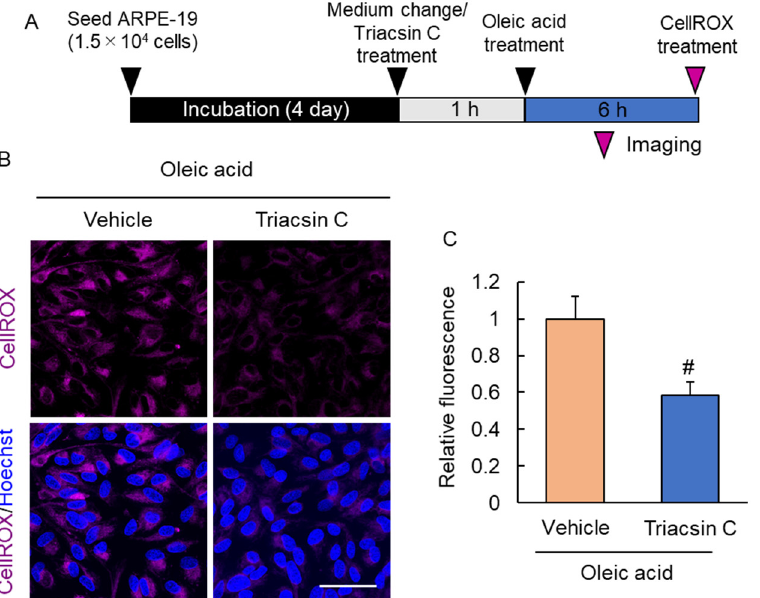
Figure 5. Suppression of ROS production by inhibition of lipid droplet accumulation. ( A ) Experimental protocol. Magenda arrow head shows CellROX staining timepoint. ( B ) The representative image of CellROX (magenta) and Hoechst 33342 (blue) after oleic acid and triacsin C treatment. Scale bar shows 50 µm. (C) The quantitative data of the CellROX intensity. Data are the means ± SEMs ( n = 4 independent experiments). # p < 0.05 vs. vehicle (Welch’s t -test).